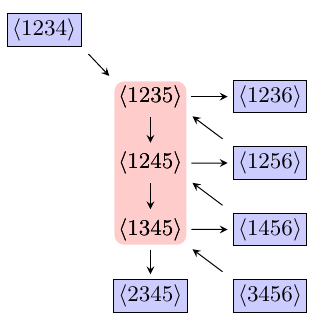
Figure 21. A cluster in A 3 corresponding to the six-point N 2 MHV